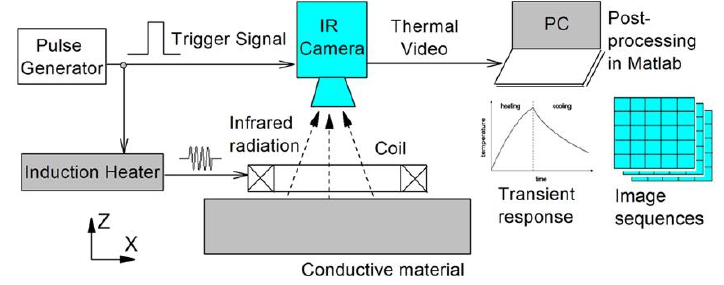
Figure 1. Schematic diagram of eddy current pulsed thermography (ECPT).